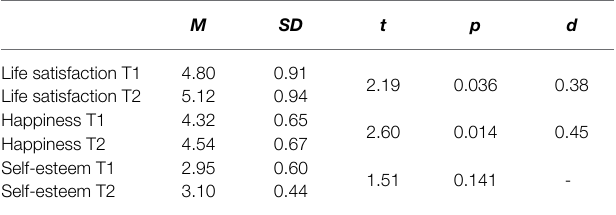
TABLE 2 | Comparison of life satisfaction, happiness, and self-esteem in the group of beginners before and after 4 weeks of physical activity. M SD t p